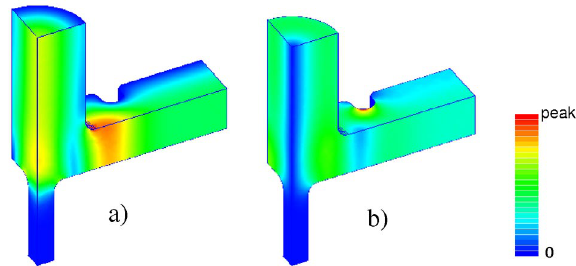
FIG. 2. (Color) Quarter geometry of TM (a) electric field and (b) magnetic field plots. Red indicates highest field and blue lowest.